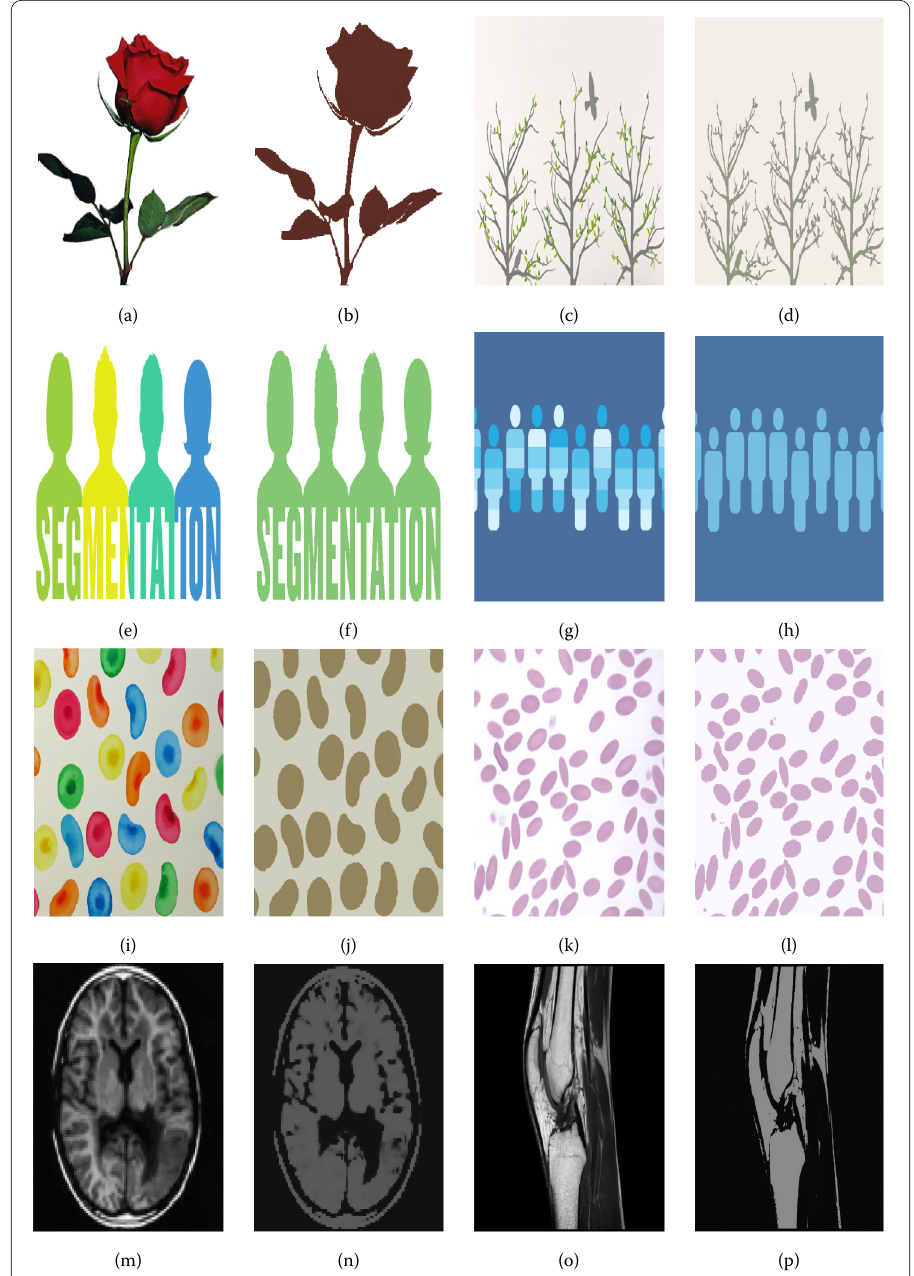
Figure 4 Original images are in column 1 and column 3 and their respective segmented results using our proposed model are given in column 2 and column 4. Results of real images are given in 1st row, while those of synthetic, biological cells, and medical images are given in 2nd, 3rd, and 4th rows,